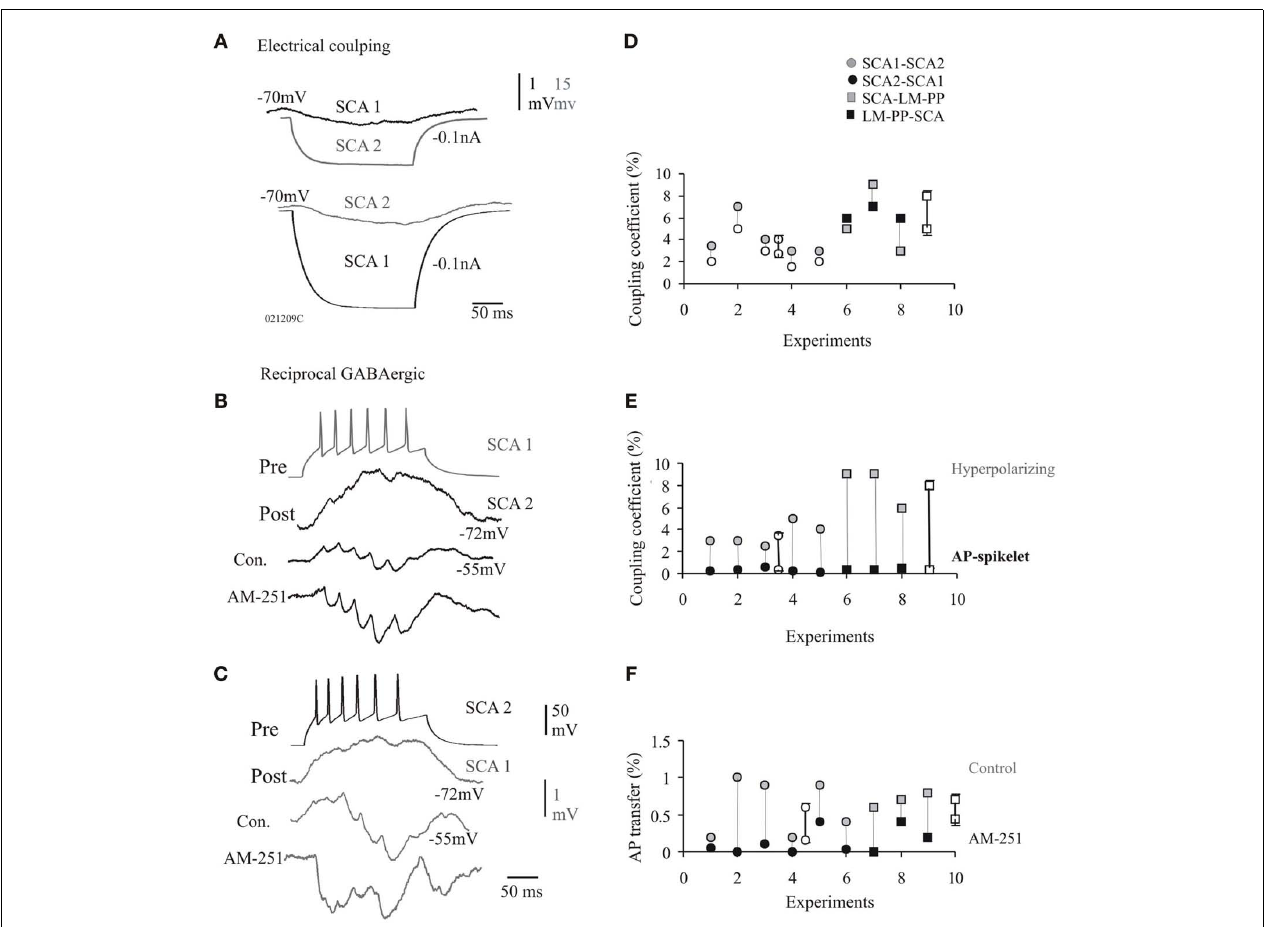
antagonist, AM-251, which further reduced the passive electrical transfer. (D) The transfer of voltage was asymmetric at electrical synapses that were also chemically connected. (E) Similar to pure electrical synapses the efficiency of transmission for fast APs was lower in comparison to the hyperpolarizing phases of the APs. (F) The AP transfer in control and bath application of AM-251 is shown for individual pairs.The AP transfer was reduced in AM-251 (probably as a result of enhanced IPSPs). Data for individual pairs are shown in (C,E,F) , average values ± SE are represented by empty